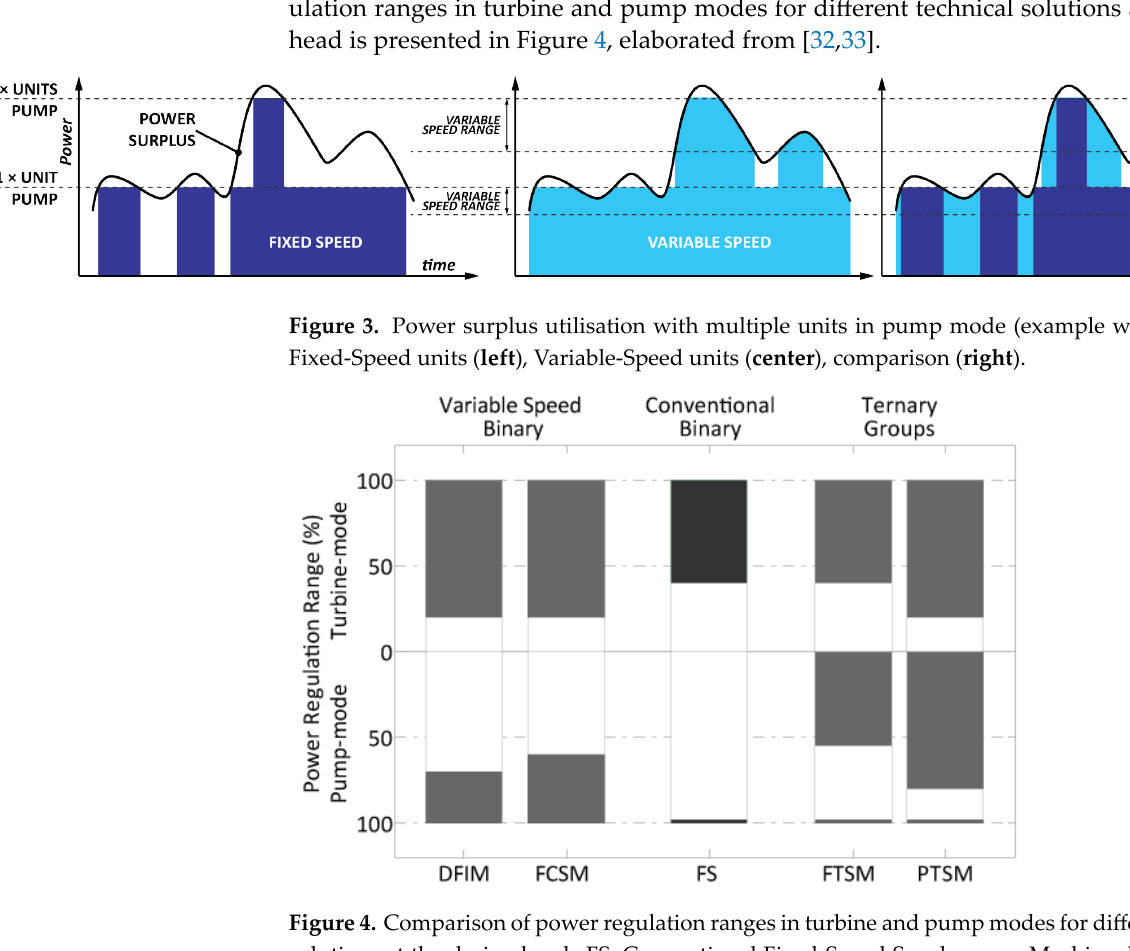
Figure 4. Comparison of power regulation ranges in turbine and pump modes for different technical solutions at the design head. FS: Conventional Fixed-Speed Synchronous Machine; DFIM: Double Fed Induction Machine; FCSM: Full Converter Synchronous Machine; FTSM: Francis Ternary Syn- chronous Machines with Hydraulic Short Circuit; PTSM: Pelton Ternary Synchronous Machines with Hydraulic Short Circuit.